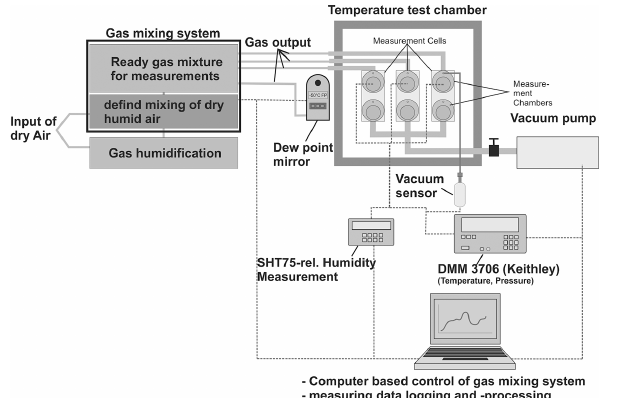
Figure 1. Experimental setup.